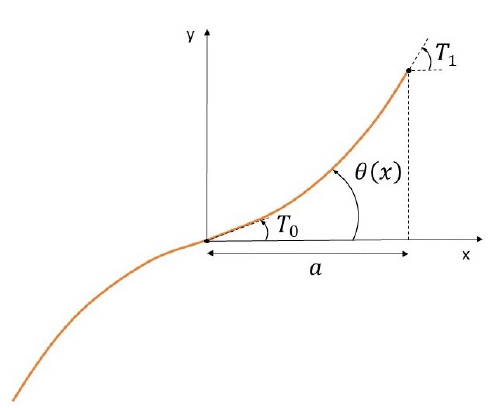
Figure 1. Reference path defined by the the linear variation of the fiber